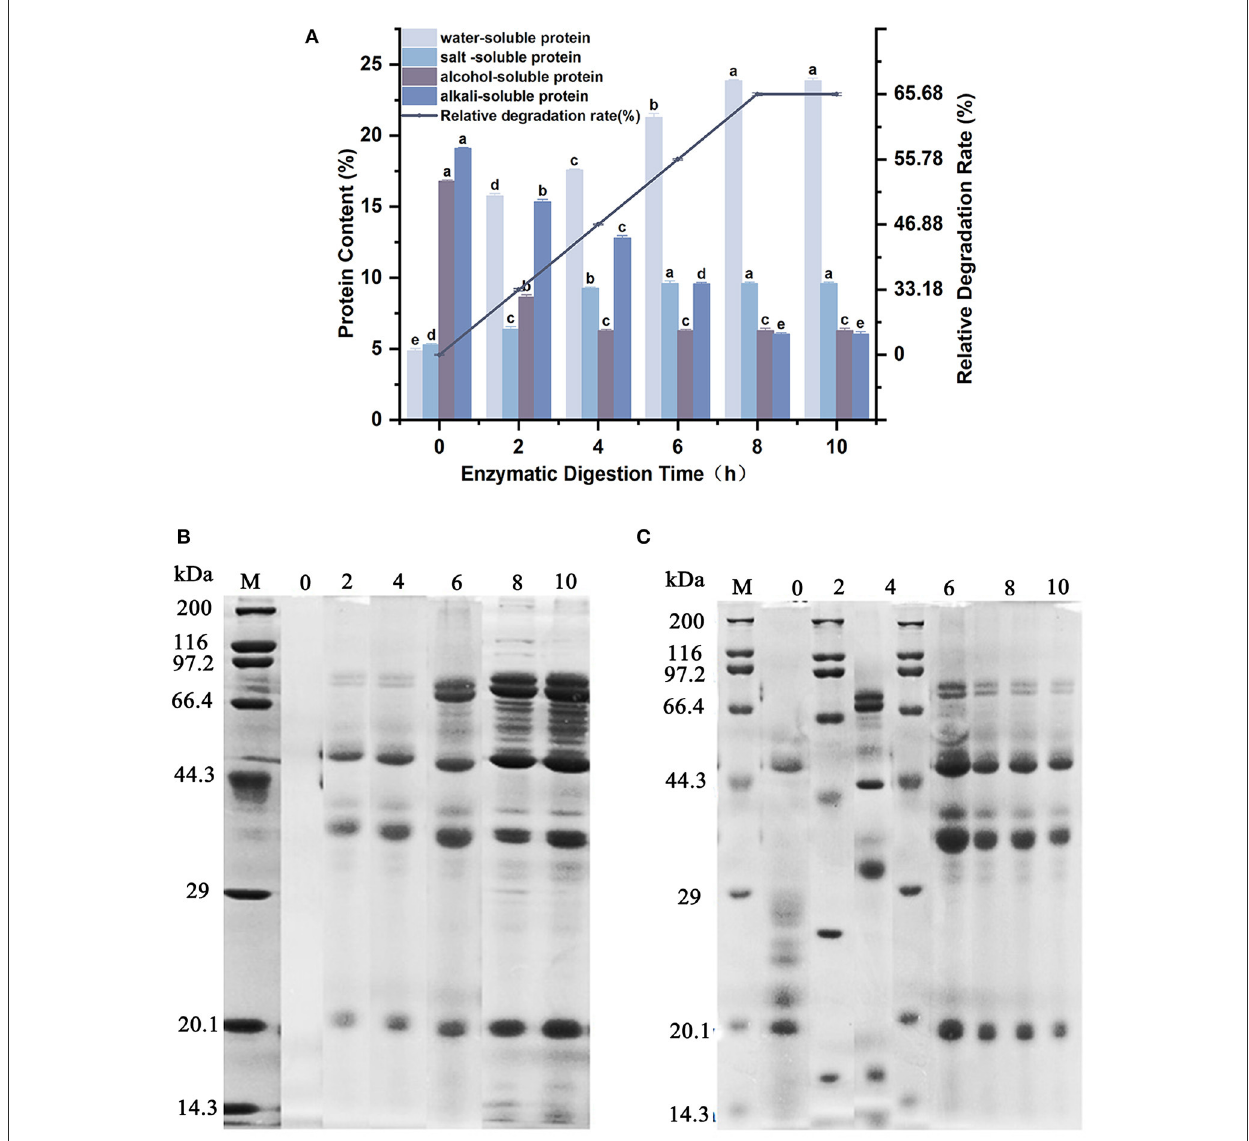
FIGURE3 Effect of enzymatic digestion on the enzymatic protein content and composition of soybean meal. (A) Changes in protein content of soybean meal during enzymatic digestion. (B) Molecular weight distribution of water-soluble proteins in the enzymatic digestion product system. (C) Molecular weight distribution of salt-soluble proteins in the enzymatic digestion product system. Different lowercase letters (a–e) indicate significant differences between data at the 95% confidence